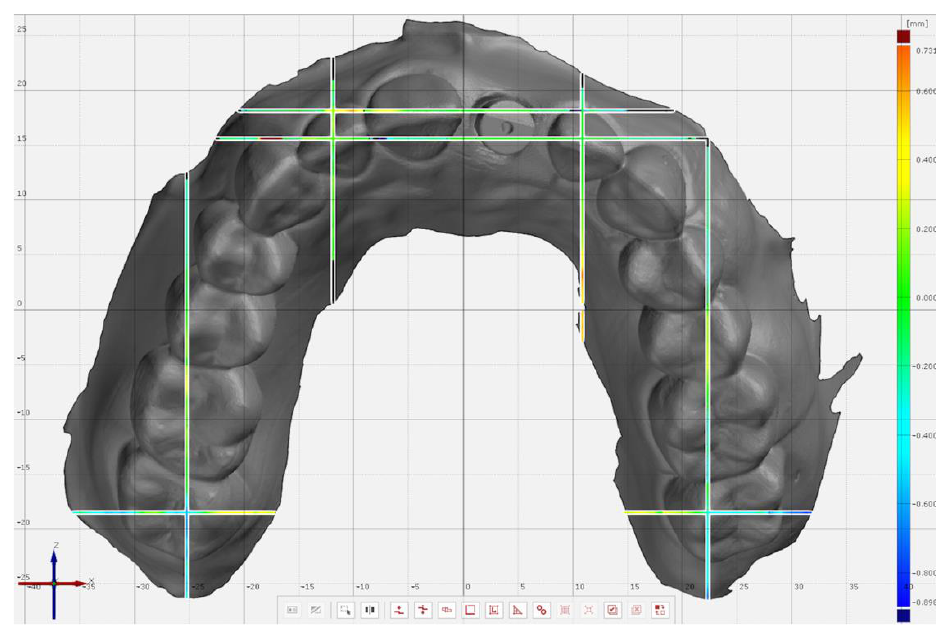
Figure 1. Complete-arch intraoral scan including the planes for subsequent analyses.